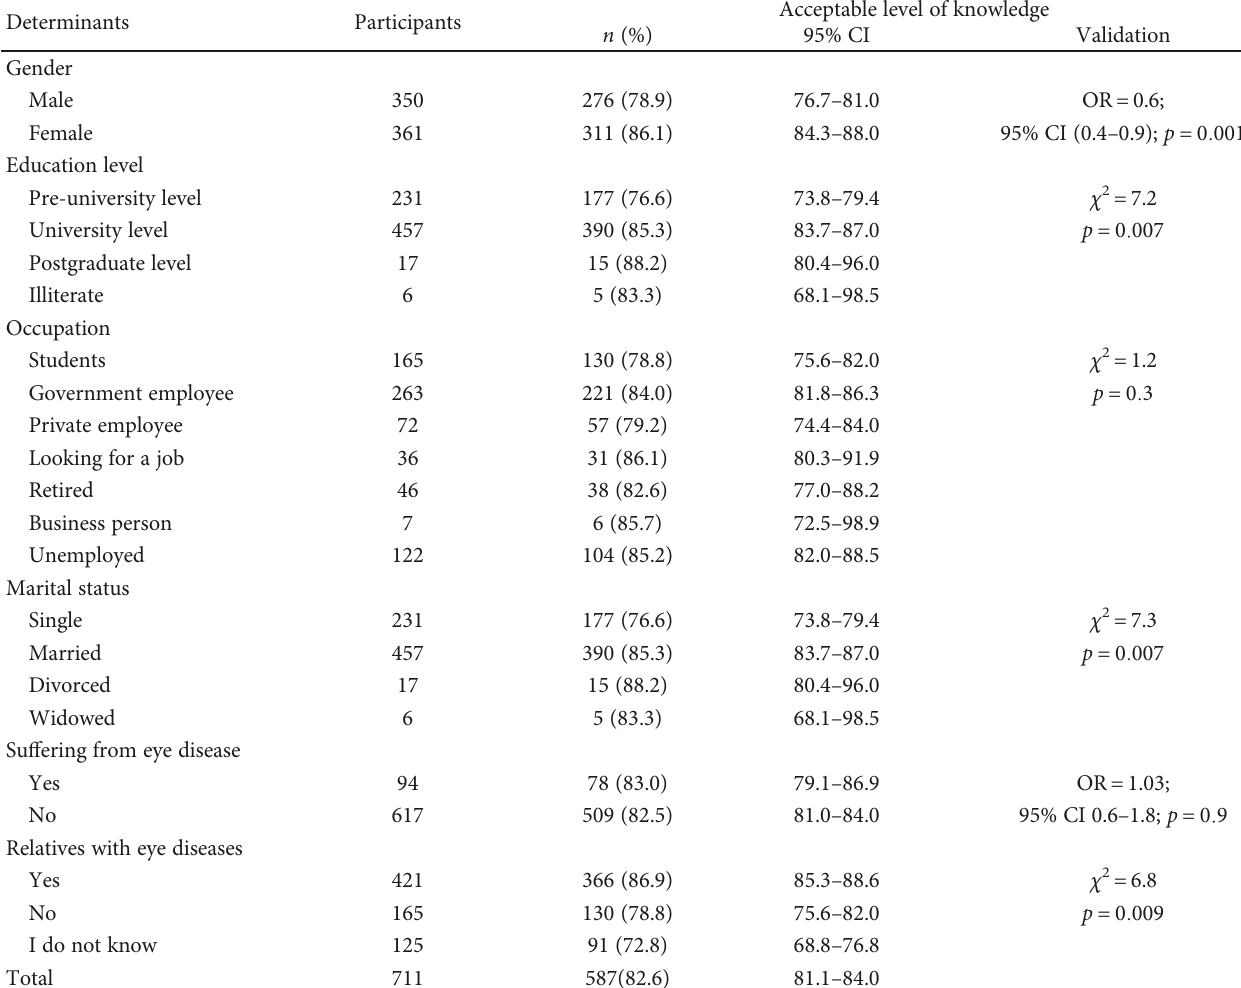
Table 2: Acceptable level of knowledge about the eye care and eye diseases among Saudi adults in Riyadh city 2016.